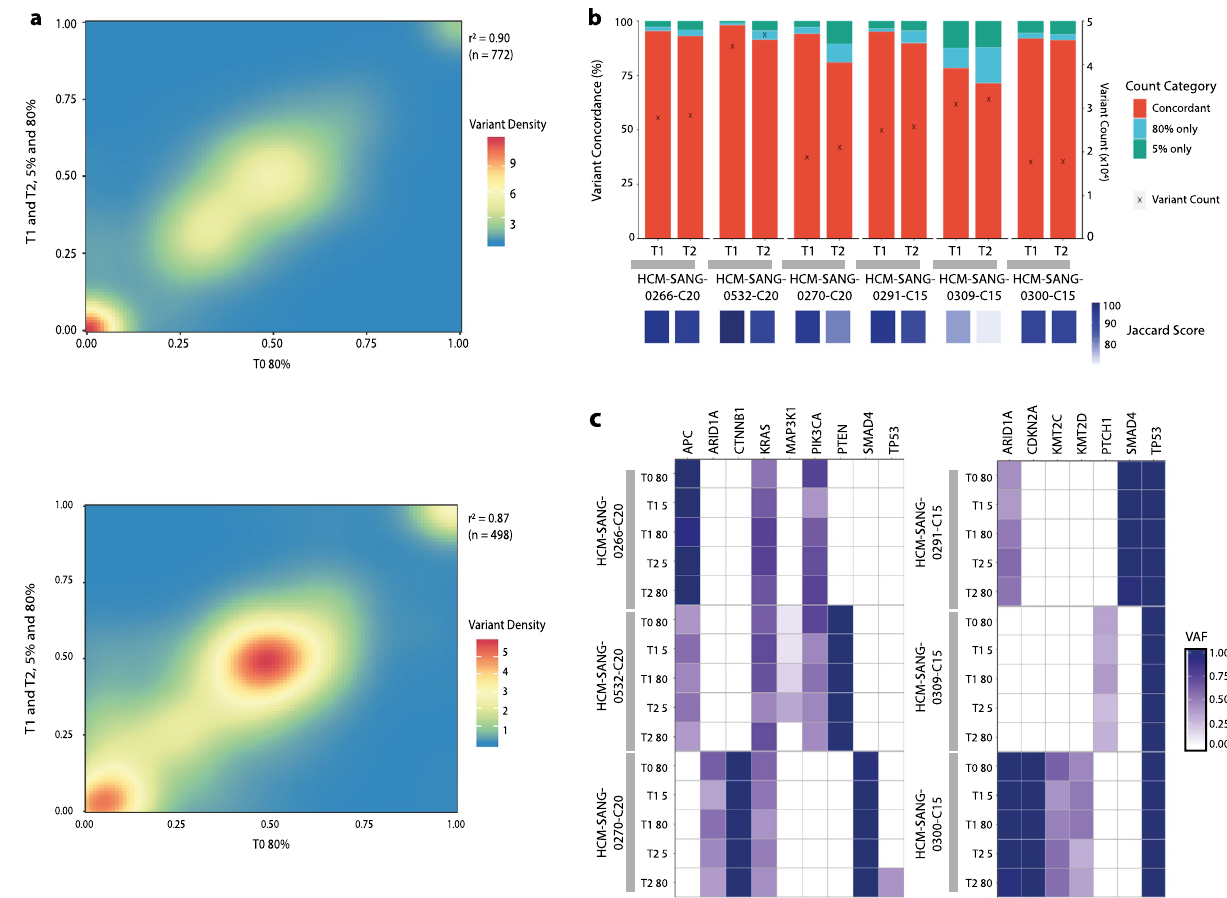
Figure 2. Genomic stability analysis. ( a ) Correlation density plot of the VAF for all non-synonymous variants at T0 in standard 80% ECM conditions with all other time points in both culture conditions, for the three colon models (top) and three oesophageal models (bottom). ( b ) Percentage concordance of mutations with a VAF greater than 0.05 for each model with associated Jaccard index scores at T1 and T2. Total somatic variant count at T1 and T2 is indicated with an (x) and is shown on the secondary y-axis. ( c ) Intogen database filtered cancer- specific driver gene VAF heat maps for colon samples (left) and oesophageal samples